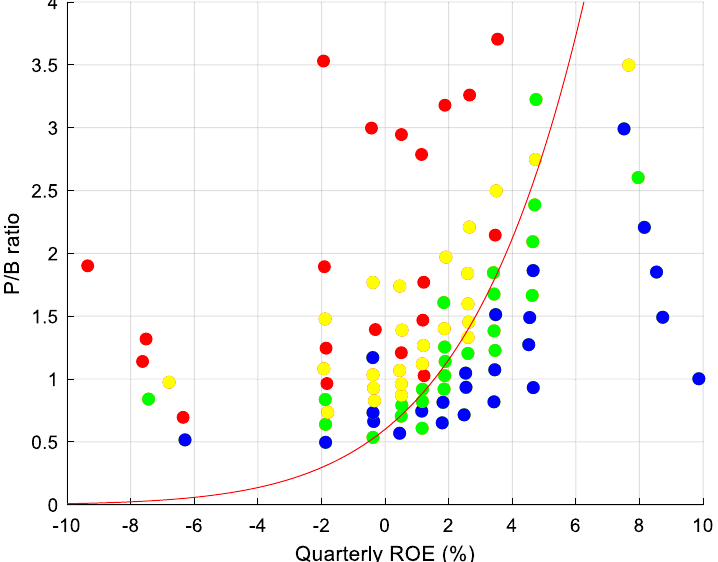
Fig. 31 The relationships among the ROE(t), the P/B(t), and quarterly return rate (t yellow: 25–50%, green: 50–75%, blue: